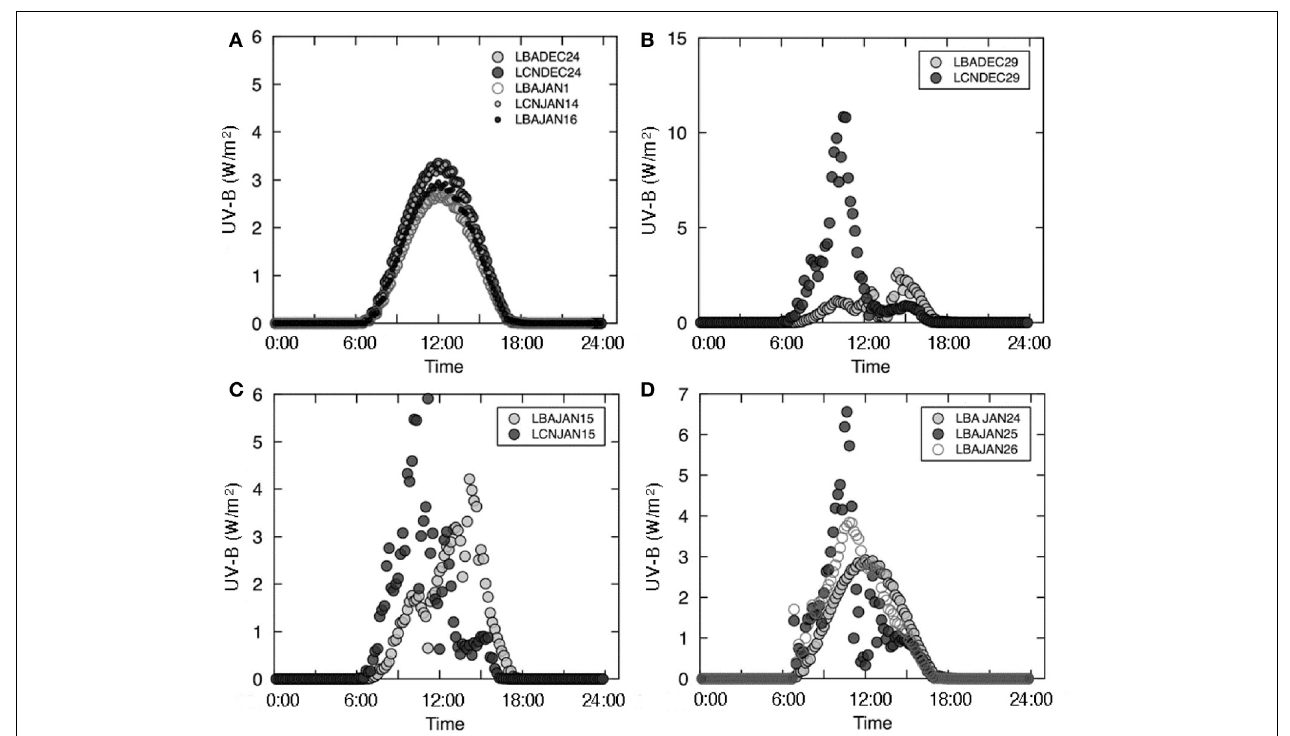
cloudy conditions. (C) On January 15, both dosimeters high values; and (D) BetweenJanuary24and26,theLBAinstrumentshowsasuccessionofnormal day, atypical spike, and return to normal conditions with a residual late morning peak.Fromthis,weareconfidentthatinstrumentmalfunctioncanberuledout, and that profile shapes during events are, instead, diagnostic of the conditions leading to the generation of these record